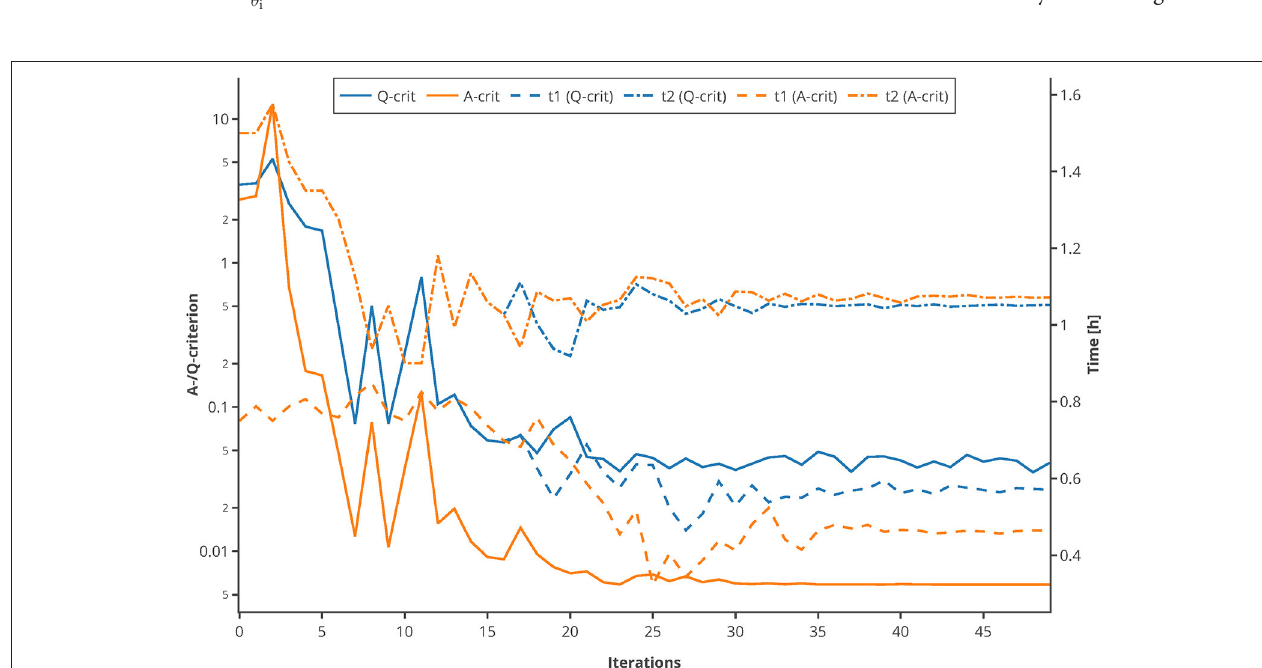
FIGURE 10 | Comparison of A-/Q-criterion guided optimization of sampling points. The values of the two criteria as well as the suggested sampling points are shown. An interactive version of this plot can be found at: https://www.tu-berlin.de/?204660.